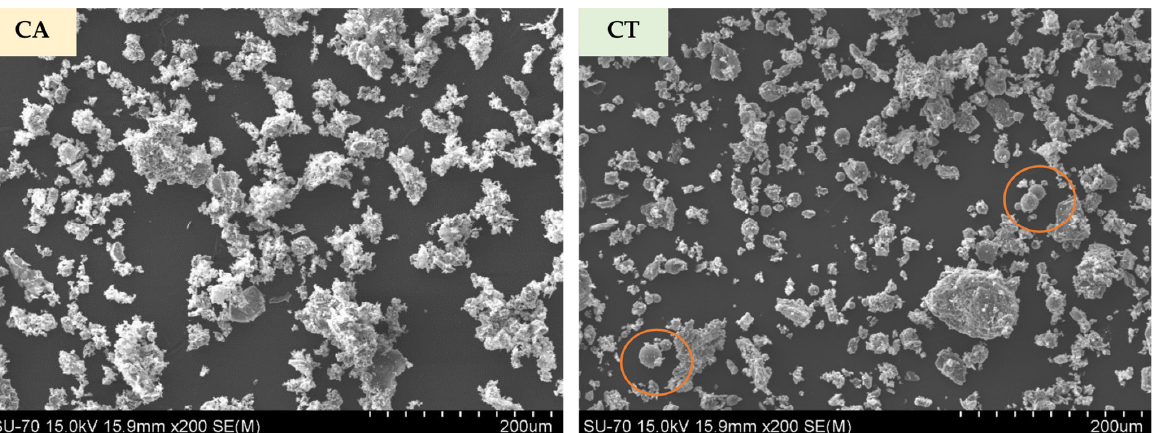
Figure 3. Granulometric distribution of CA and CT biomass fly ashes.